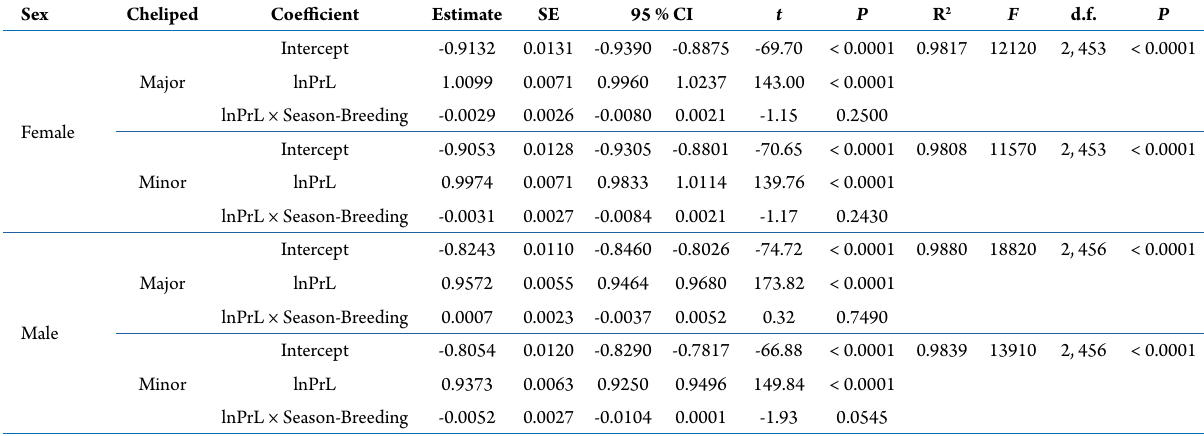
Table A2. Coefficient estimates with standard errors (SE) and their 95 % confidence intervals (CI) for the explanatory variables of log-transformed allometric growth equation models to evaluate the intrasexual chela shape dimorphism of major or minor chelipeds between the breeding (May to September) and non-breeding seasons (October to April) in each sex of the porcellanid crab Petrolisthes japonicus . The linear equation model was as follows: lnPrW = ln a + b lnPrL+ c lnPrL× Season, where PrW is the cheliped propodus width, PrL is the cheliped propodus length, and Season is the breeding season or non-breeding season. The coefficient estimate for each explanatory variable, including the Season, was the output for the breeding season, representing changes in the response variable relative to the baseline category (non-breeding season). The statistical significance of the coefficient estimates and each model was evaluated with t -tests and F -tests, respectively.